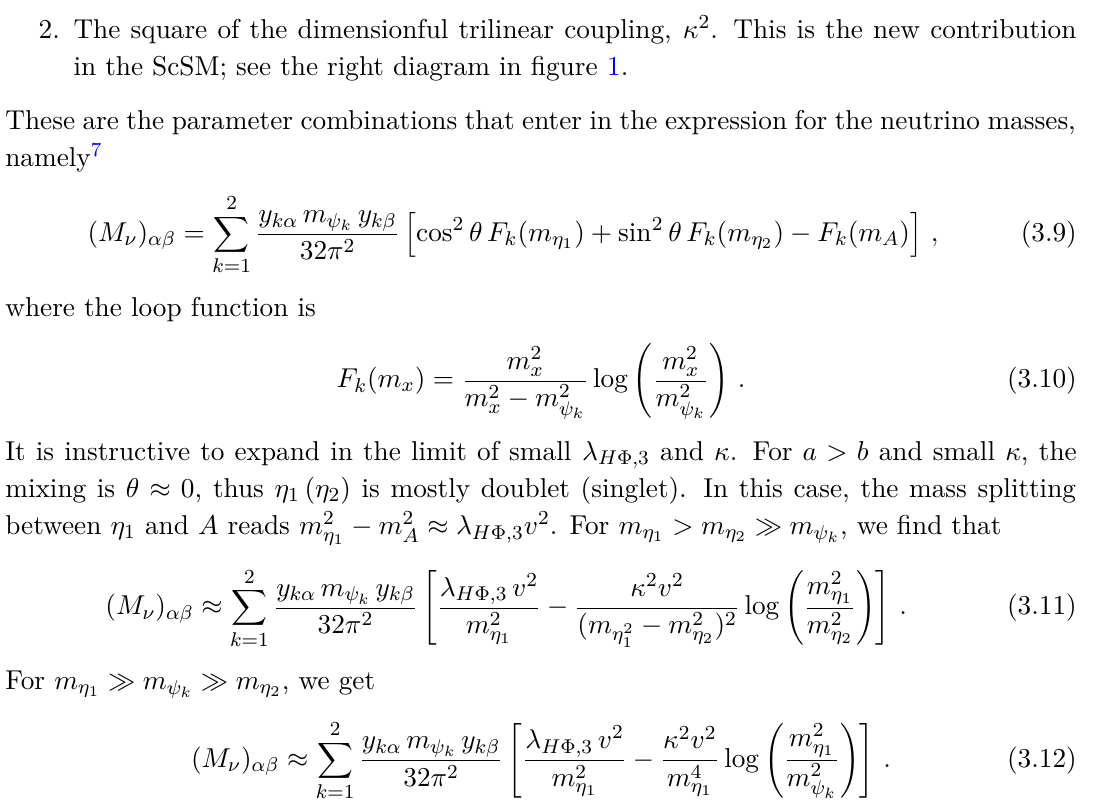
), whereas the right panel shows H Φ , 3